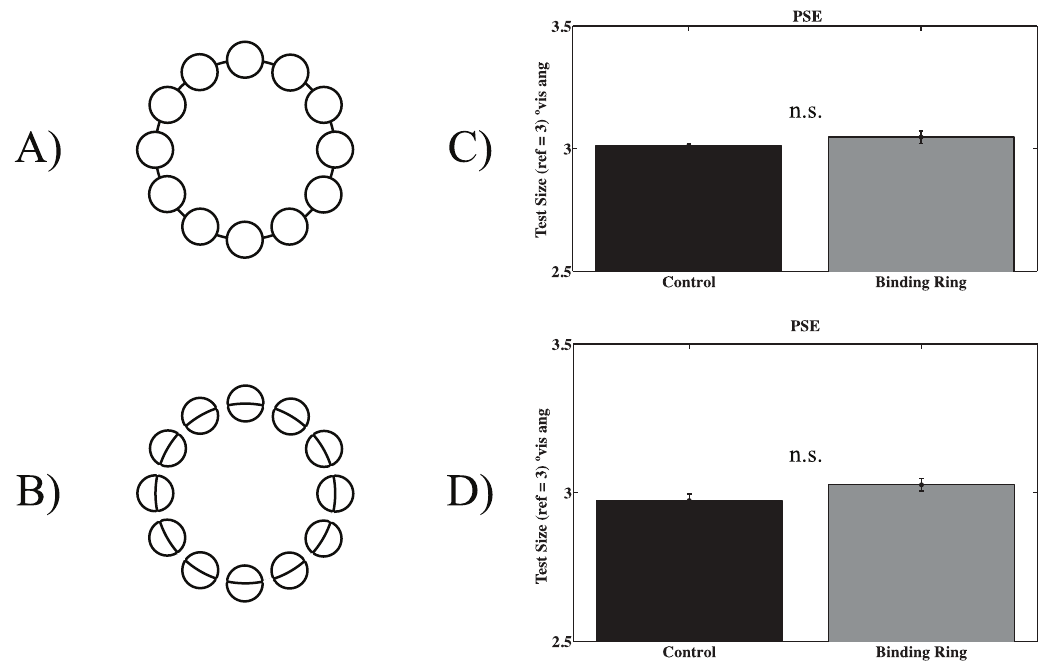
Figure 7. Configurally altered binding ring stimuli. A ) The test stimulus used in experiment 4a. B ) The test stimulus used in experiment 4b. C ) The results of experiment 4a. D ) The results of experiment 4b. There was no significant difference (n.s.) in perceived size between the control and binding ring tests in either